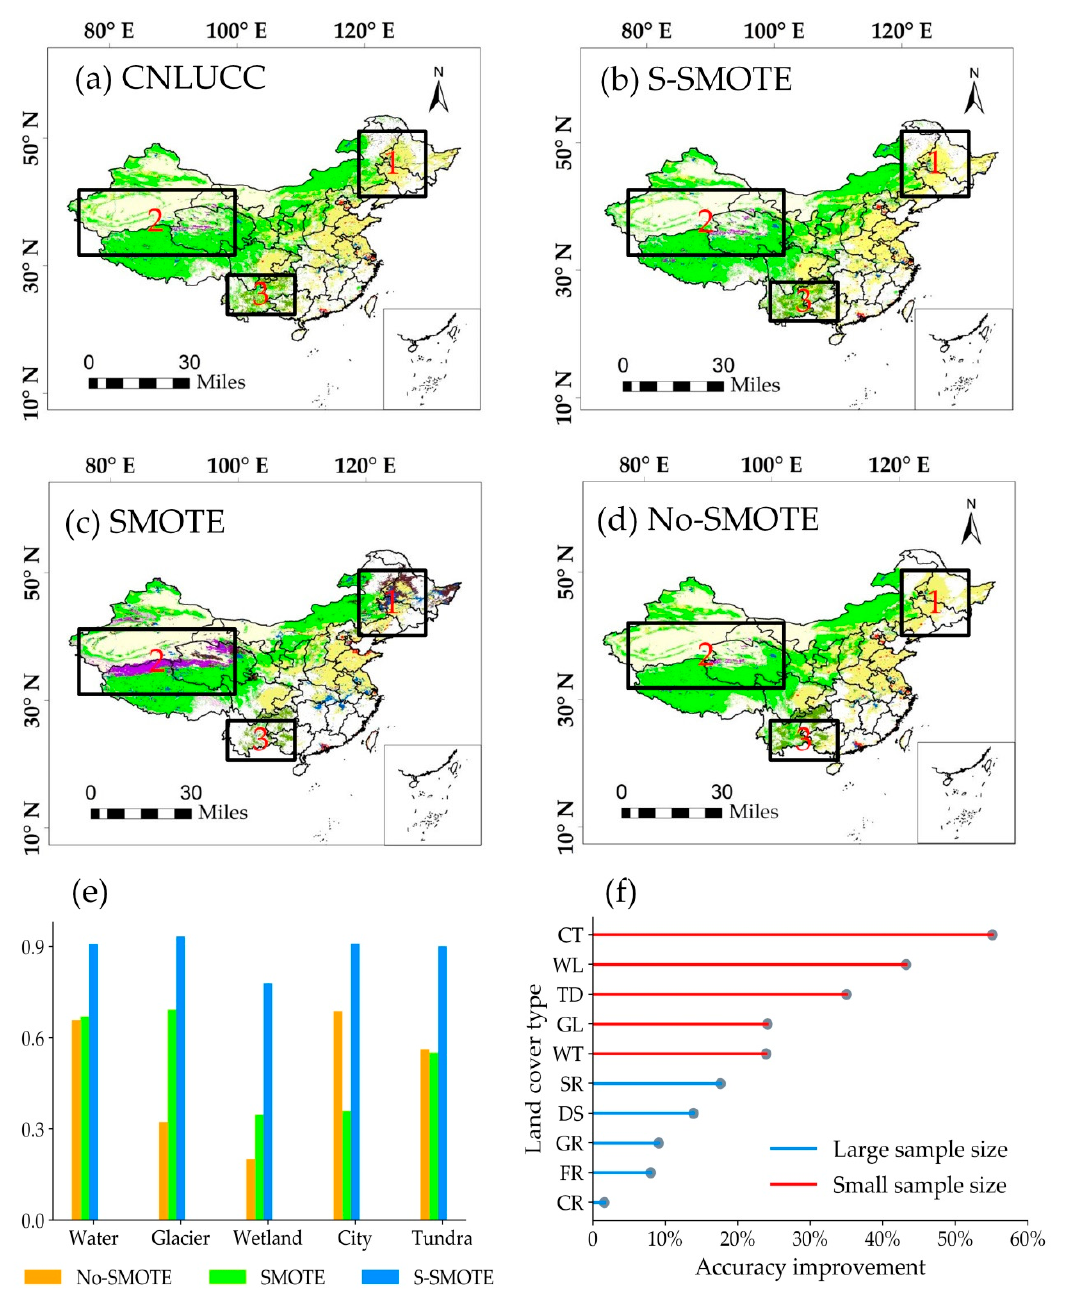
Figure 11. ( a ) The CNLUCC original classification data, ( b ) the use of the stratified SMOTE algorithm, ( c ) the use of the SMOTE algorithm and ( d ) No use of the SMOTE algorithm. ( e ) Column contrast comparison, with an accuracy improvement of more than 20% and ( f ) large sample (Sample size is greater than 90 k) and small sample (Sample size is less than 90 k) category accuracy improvement trend